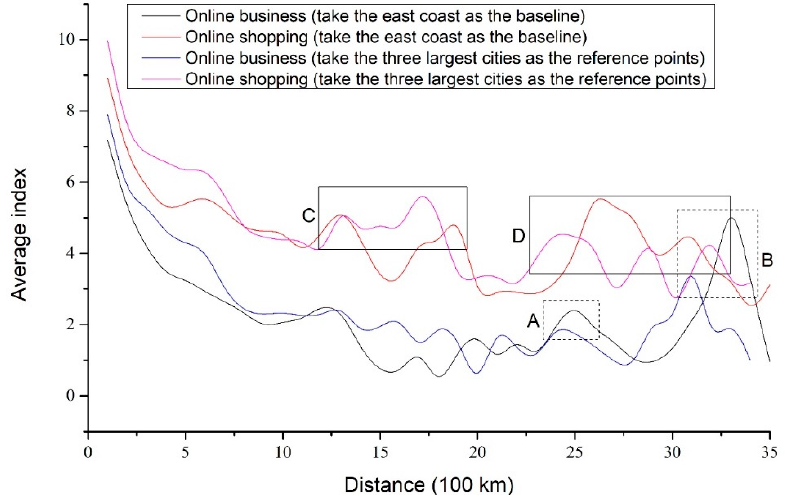
Figure 4. Average index of online business and online shopping decaying with distance. A, B, C and D are crests of online business and online shopping.